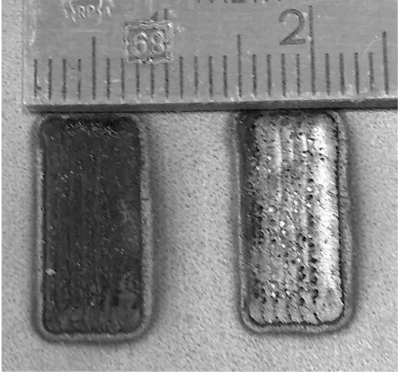
Figure 13. A view of specimens prepared for XRD analysis (from left: HC4 and CL4; see Table 3).